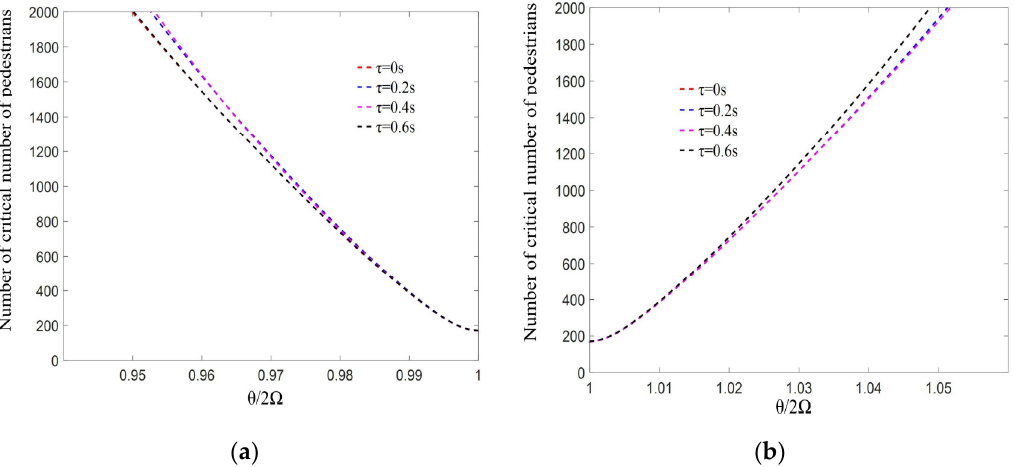
Figure 3. Relationship curve of right border–left border at midspan corresponding to different time-delay coefficients. ( a ) Left border. ( b ) Right border.